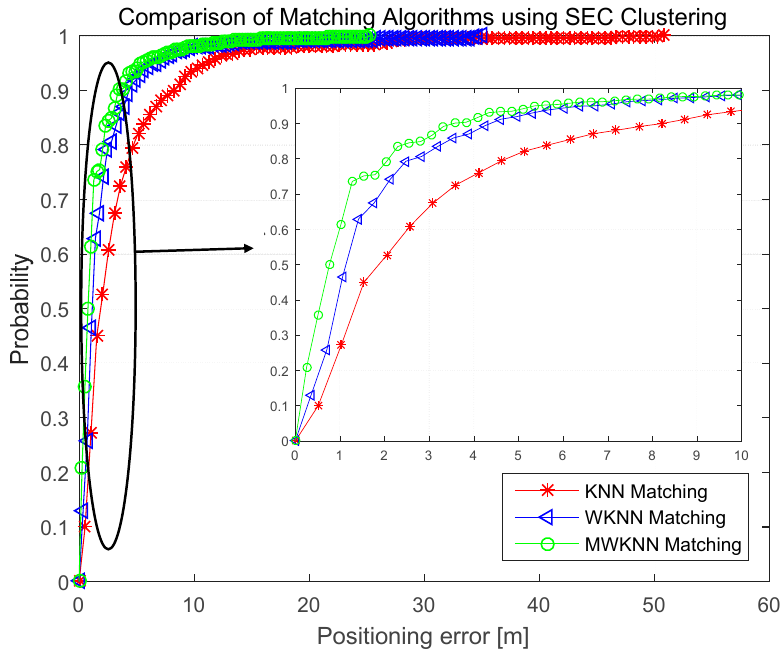
Figure 11. Comparison of matching algorithms using SEC clustering.